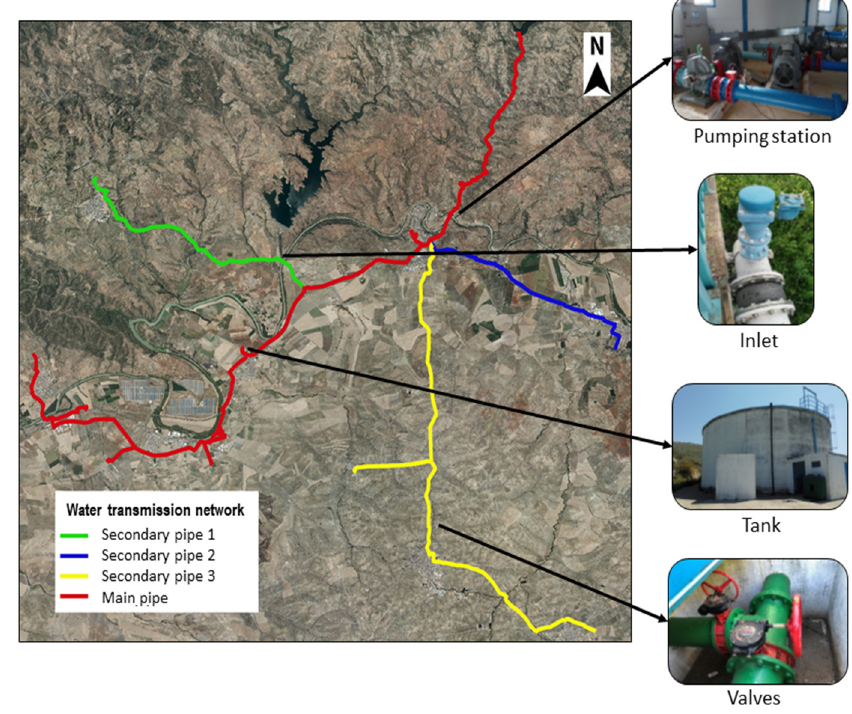
Figure 4. Geographical information system of the Eastern System.